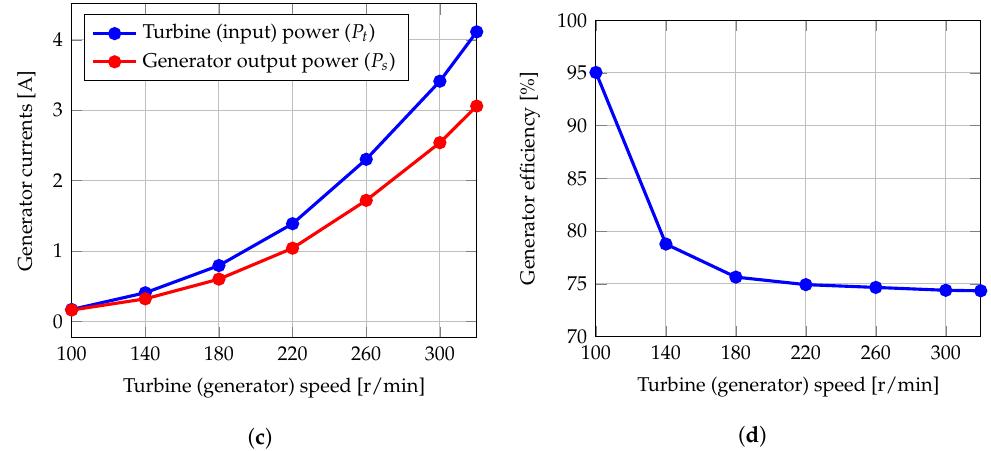
Figure 23. Experimental steady-state performance of the proposed MPPT wind generator current control as a function of speed. ( a ) Generator output current ( I q )( I d = 0 ) and field current, ( b ) FEA- predicted and -measured MPP turbine power, ( c ) mechanical turbine input power, P m and electrical generator stator output power, P s , and ( d ) efficiency.